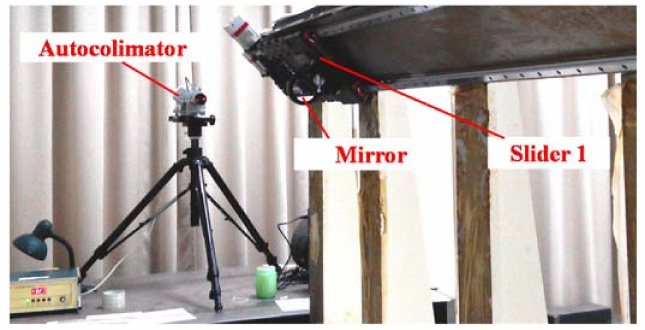
Figure 4. Measurement of straightness of two rails.